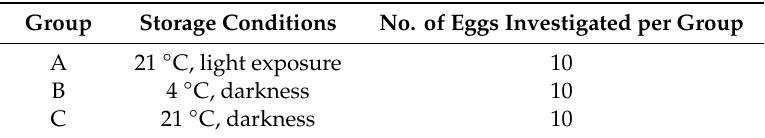
Table 1. Storage conditions tested to influence the separation of the inner perivitelline membrane (IPVM) of unfertilized chicken